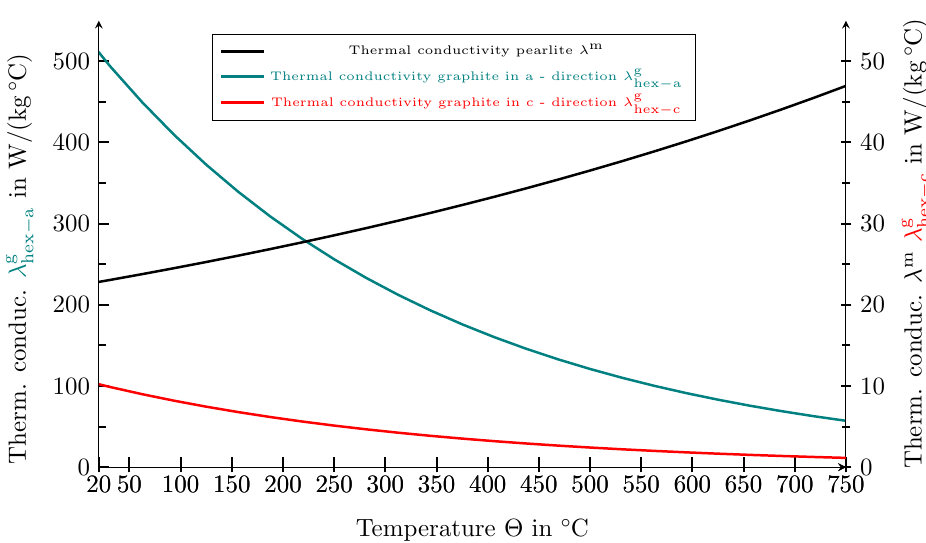
Figure 6. Temperature-dependent thermal conductivities. Isotropic thermal conductivity of the pearlitic matrix, λ m , according to Helsing and Grimvall [34]. Components of the transversely isotropic thermal conductivity of the graphite lamellae λ g and Grimvall [34].